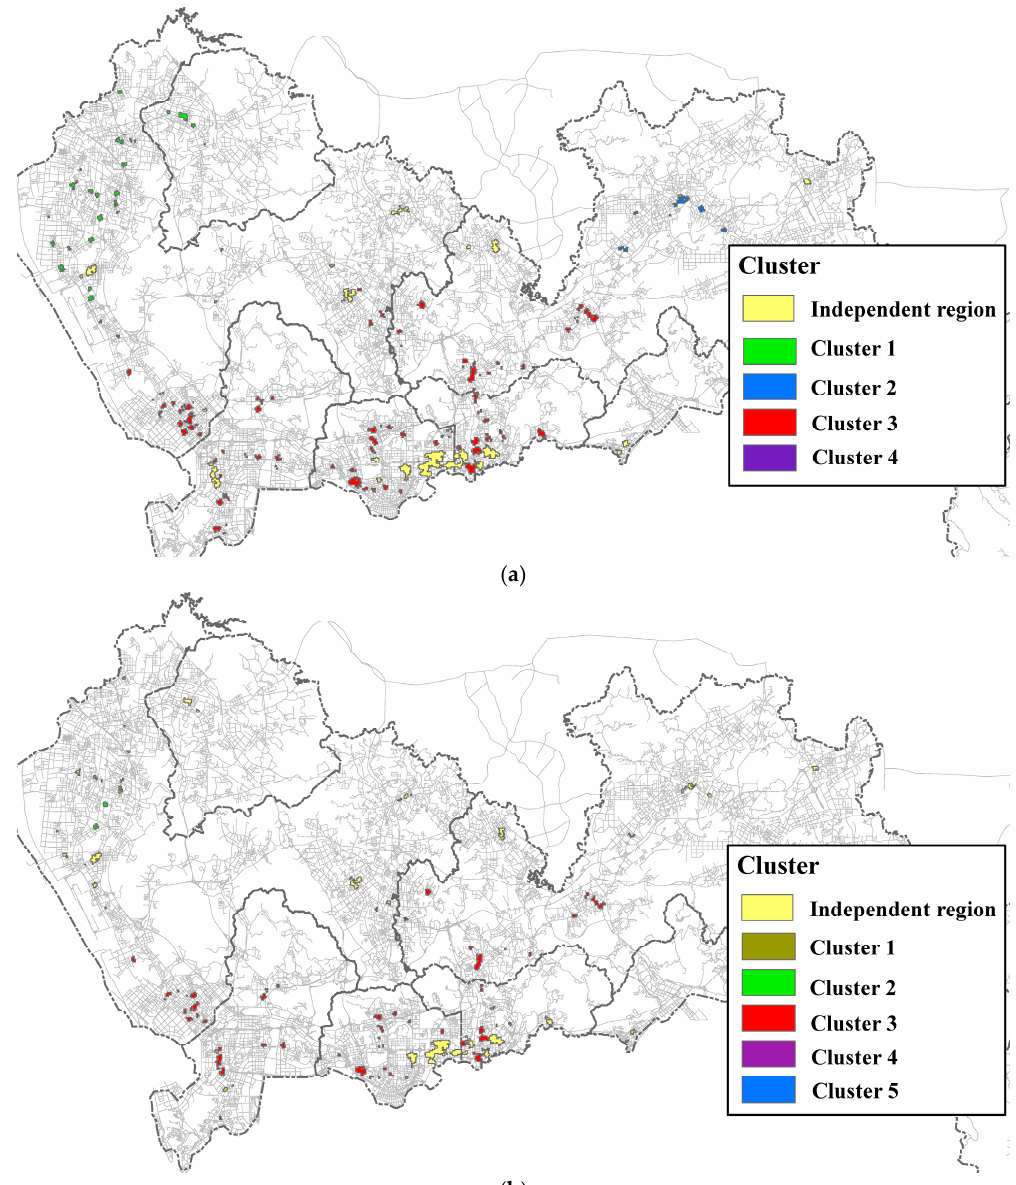
Figure 15. Results of clustering prevalent regions using the prevalence threshold: ( a ) PI = 3; and ( b ) PI = 7, for the size-3 pattern {bank, retail store, hotel}. The bandwidth is 300 m.